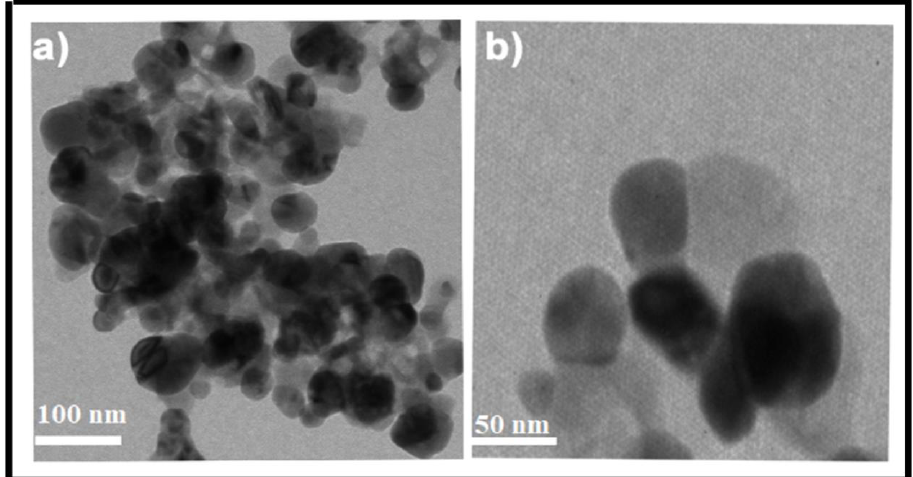
Figure 5. TEM images ( a , b ) of biosynthesized ZrO 2 NPs.